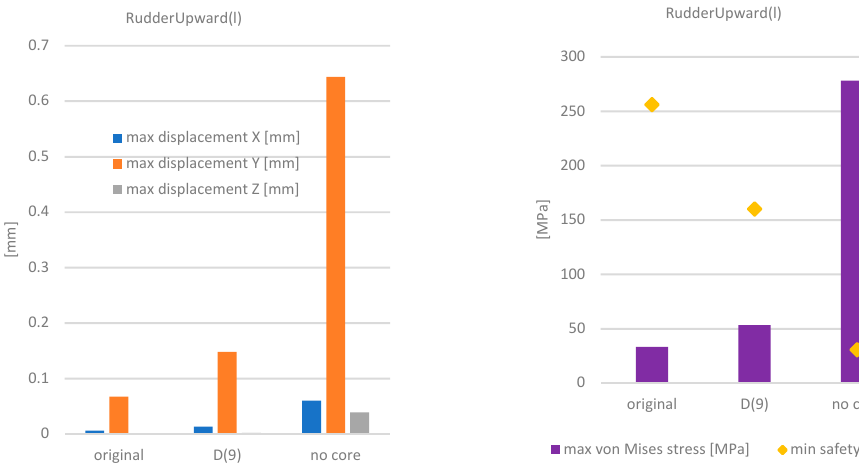
Figure 10. Capsize (clockwise, s ) load case analysis results.